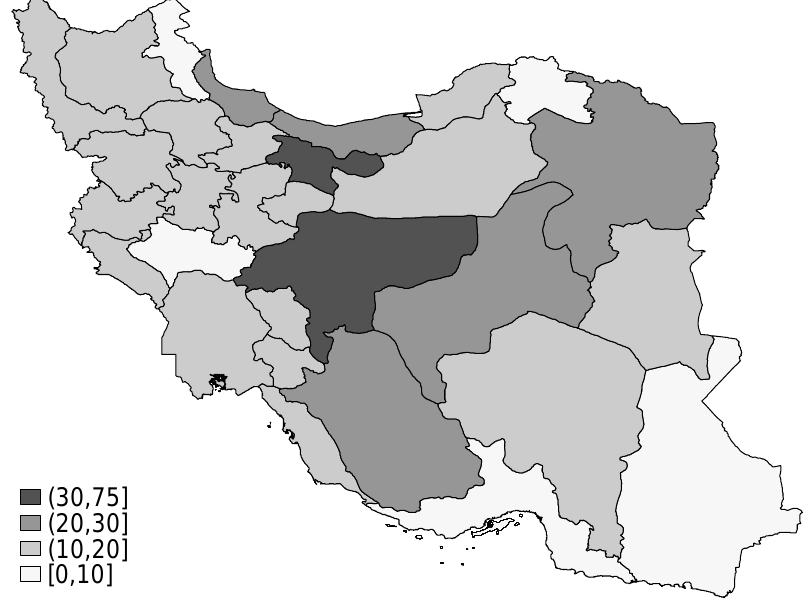
Figure 2. Lorenz curve of the distribution of dentists in Iran,